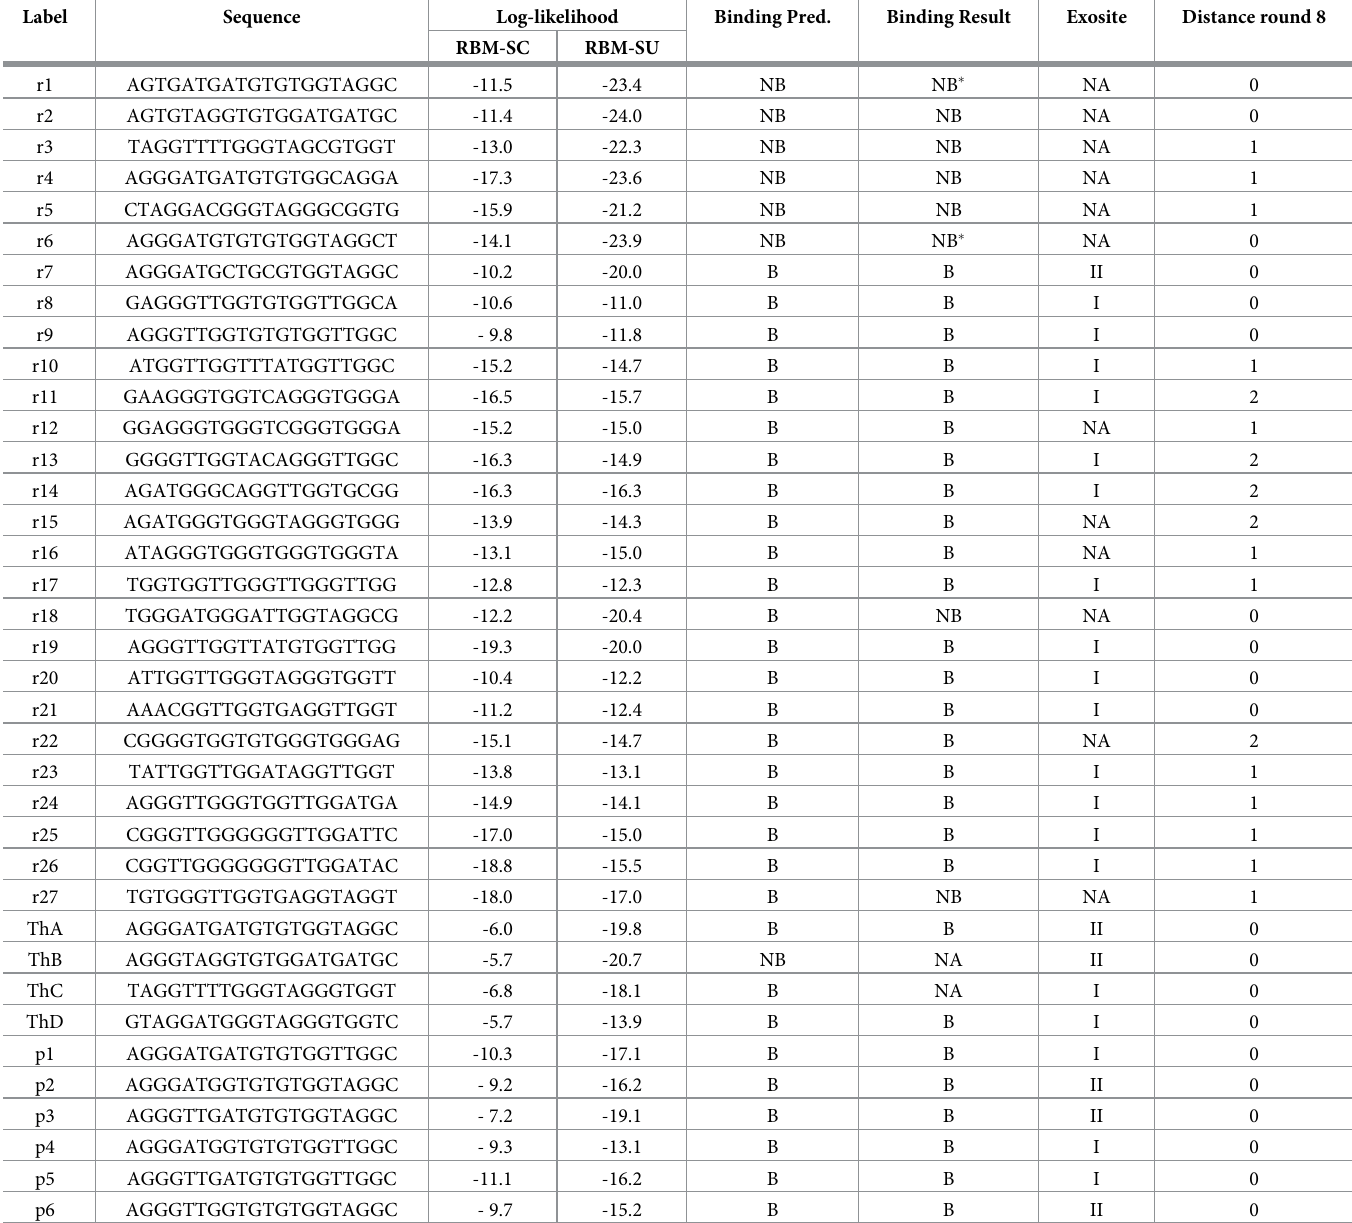
Table 1. Sequences generated from RBM-SU, log-likelihoods, binding predictions (based on the comparison of the RBM-SU log-likelihood and the threshold in Fig 5D), and results from gel shift assay (B for binders, NB for non binders) and exosite binding assays. For comparison, data for ThA, ThB, ThC and ThD sequences from Ref [41] are shown. ThB and ThC have not been tested for binding with our experimental setup (so NA is used in the corresponding column), although they are expected to bind thrombin given the results obtained in Ref [41]. Label